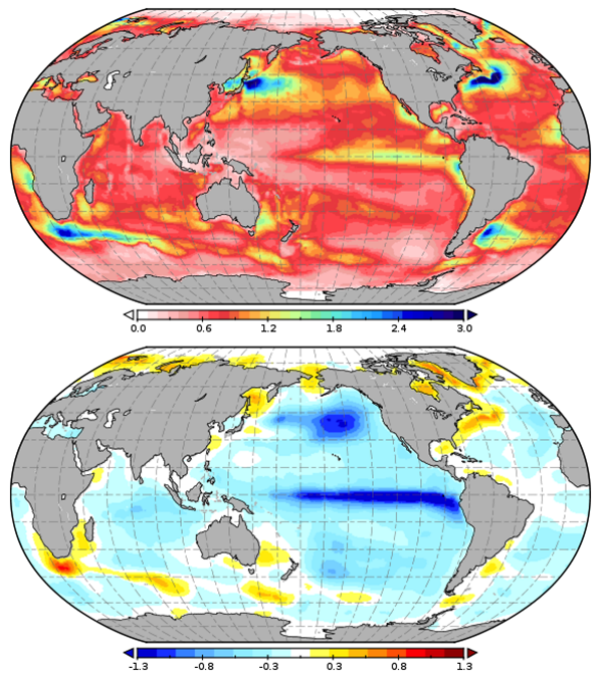
Figure 2. Season-averaged temperature background-error standard deviation in the top 10m of depth in C-GLORSv5 (top panel), and difference with respect to the background errors used in C- GLORSv4 (bottom